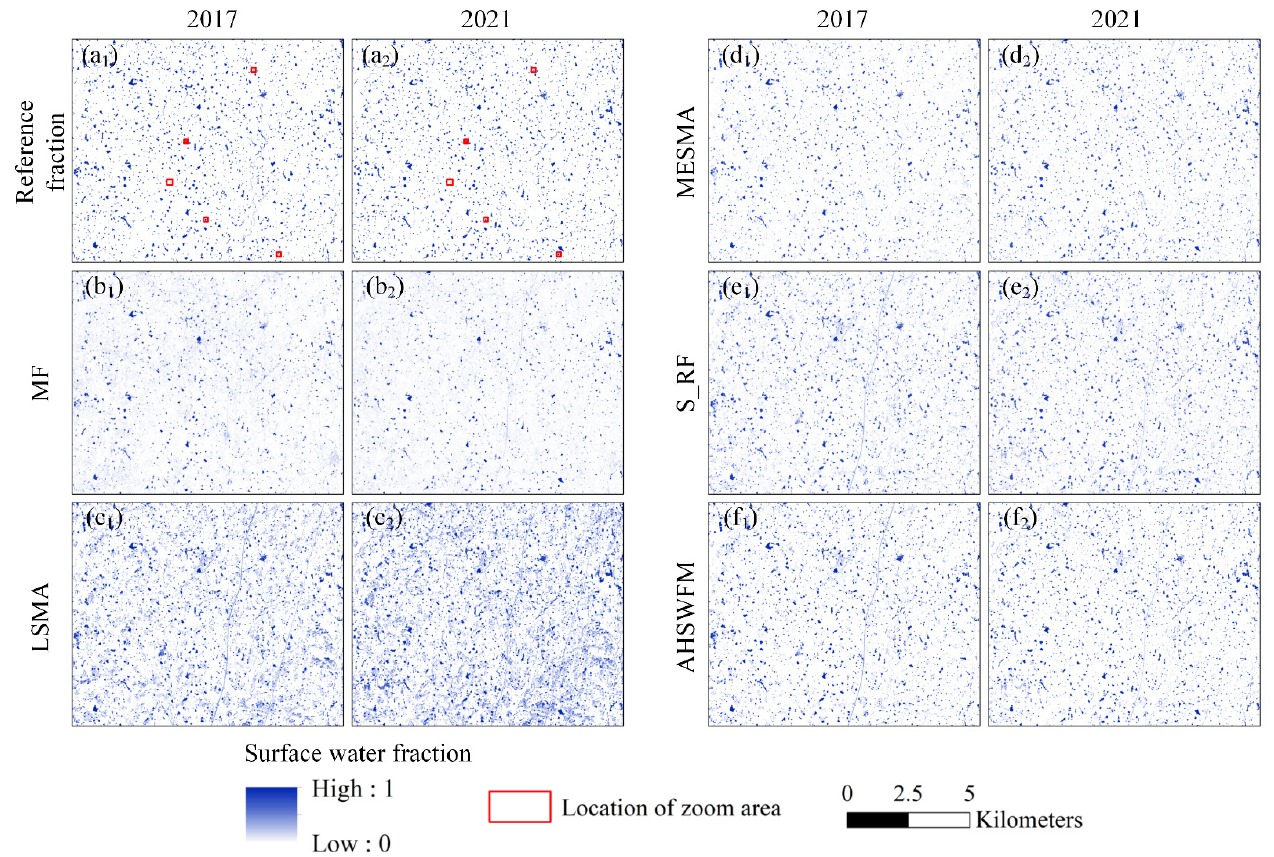
Figure 7. Comparison of water fraction maps generated using five methods in two years. ( a 1 , a 2 ) Reference water fraction maps, in which the red rectangles indicate the locations of zoomed areas of five small water bodies (SWBs) analyzed in Figure 8, ( b 1 ,b 2 ) matched filtering (MF), ( c 1 , c 2 ) linear spectral mixture analysis (LSMA), ( d 1 , d 2 ) multiple endmember spectral mixture analysis (MESMA), ( e 1 , e 2 ) self-trained random forest regression (S_RF) prediction and ( f 1 , f 2 ) automated and hierarchical surface water fraction mapping (AHSWFM). S_RF and AHSWFM with a window size of 10 and a fixed window shift in the aggregation to coarse pixel samples in the water fraction regression were used .